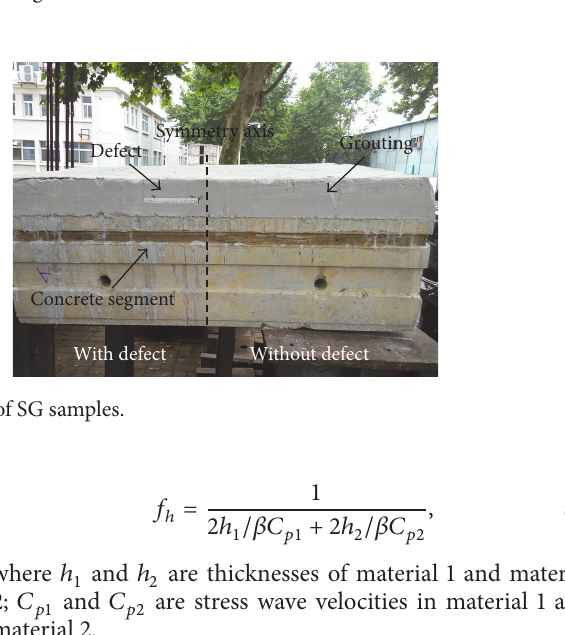
Figure 2: Concrete segments.